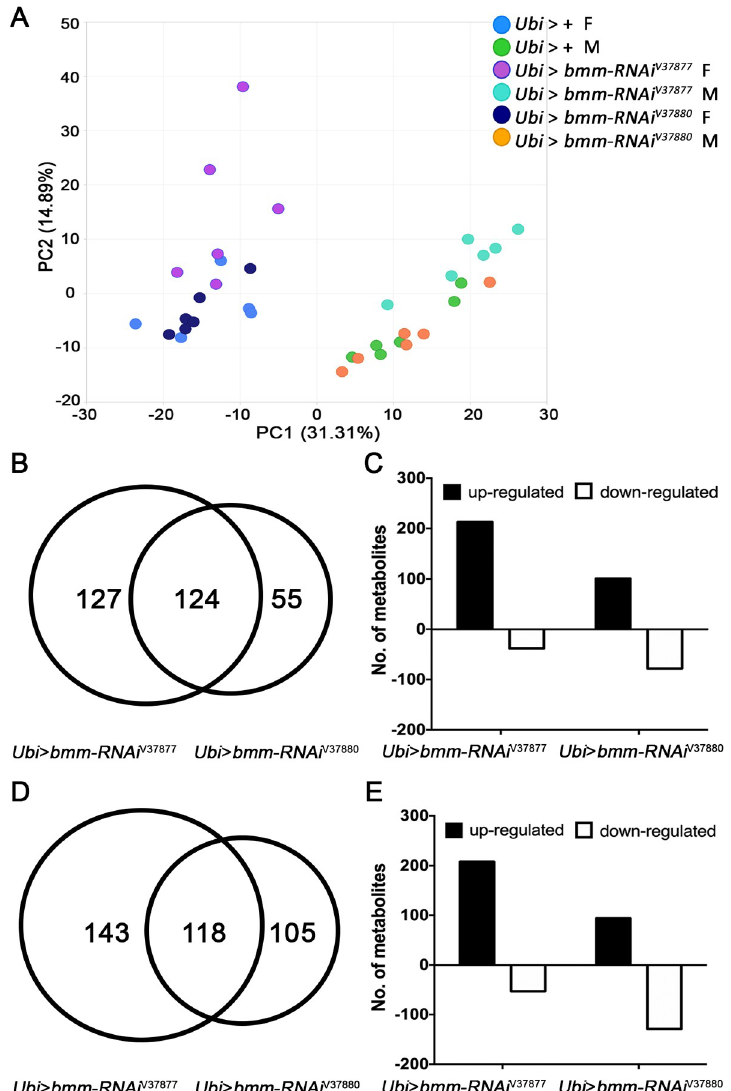
Fig 4. Metabolites with altered abundance levels in Ubi > bmm-RNAi flies. Offspring of Ubi-Gal4 mated with GD control ( Ubi > +) or UAS-bmm-RNAi flies ( Ubi > bmm-RNAi V37877 and Ubi > bmm-RNAi V37880 ) were used for metabolome analysis. F1 6-day-old adult females (F) and males (M) were used for the metabolomic profiles (n = 6). ANOVA contrasts were used to identify metabolites that differed significantly between experimental groups and corresponding controls at p � 0.05 (q-value is reported in S1 Dataset). (a) Principal component analysis of variation in the composition of the metabolome of flies in which bmm is downregulated and control flies. (b) Venn diagram of metabolites that significantly changed in Ubi > bmm-RNAi females compared with controls. (c) Number of metabolites that significantly increased (black bars) and decreased (white bars) in Ubi > bmm-RNAi females compared with controls. (d) Venn diagram of metabolites that significantly changed in Ubi > bmm-RNAi males compared with controls. (e) Number of metabolites that significantly increased (black bars) and decreased (white bars) in Ubi > bmm- RNAi males compared with